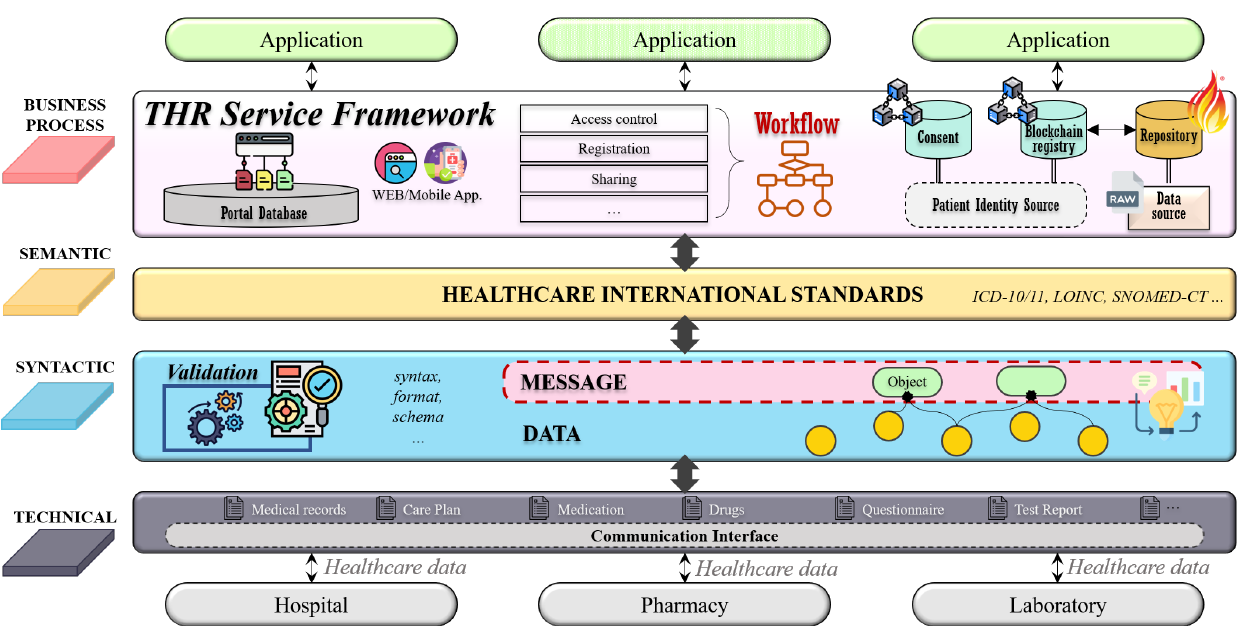
Figure 3. Layered system architecture for level-specific interoperability in the THR